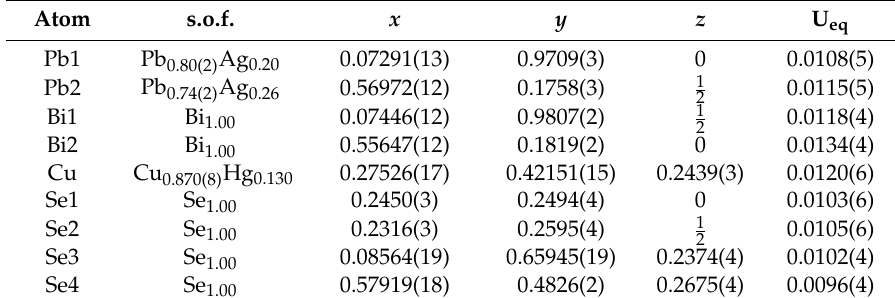
Table 6. Atoms, site occupancy factors (s.o.f.), fractional atomic coordinates ( x , y , z ), and equivalent isotropic displacement parameters (U eq , Å 2 ) for the selected cerromojonite crystal.